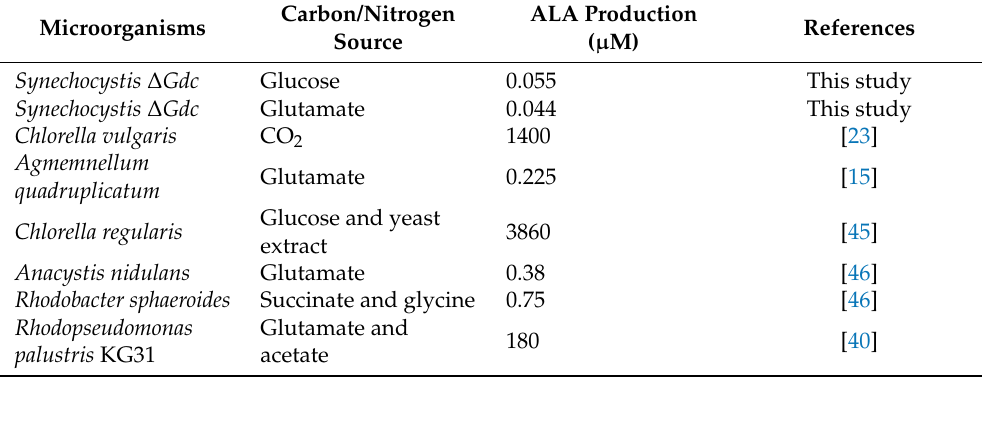
Table 2. Production of ALA by photosynthetic microbes.